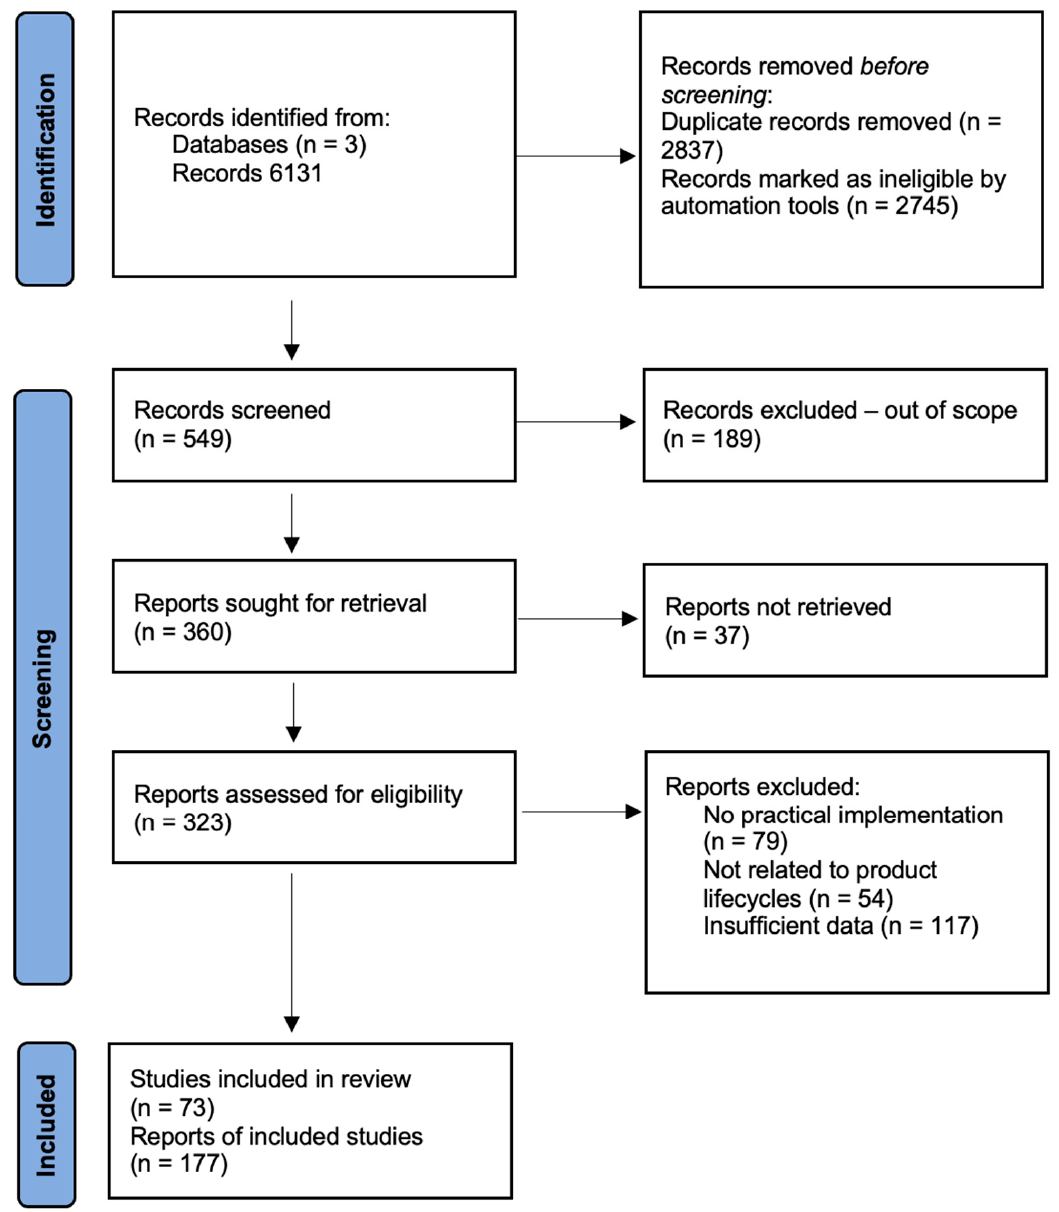
Figure 3. Identification of studies via PRISMA 2020 recommendations.